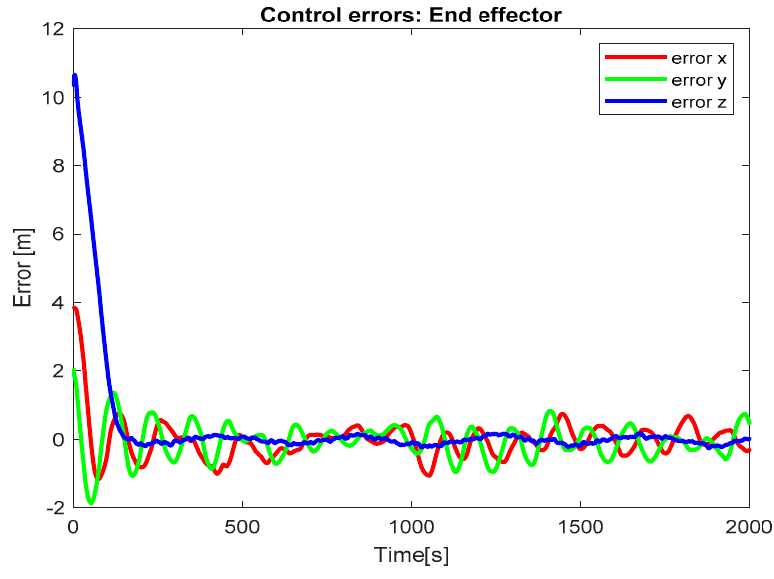
Figure 9. Control errors: Kinematic controller.